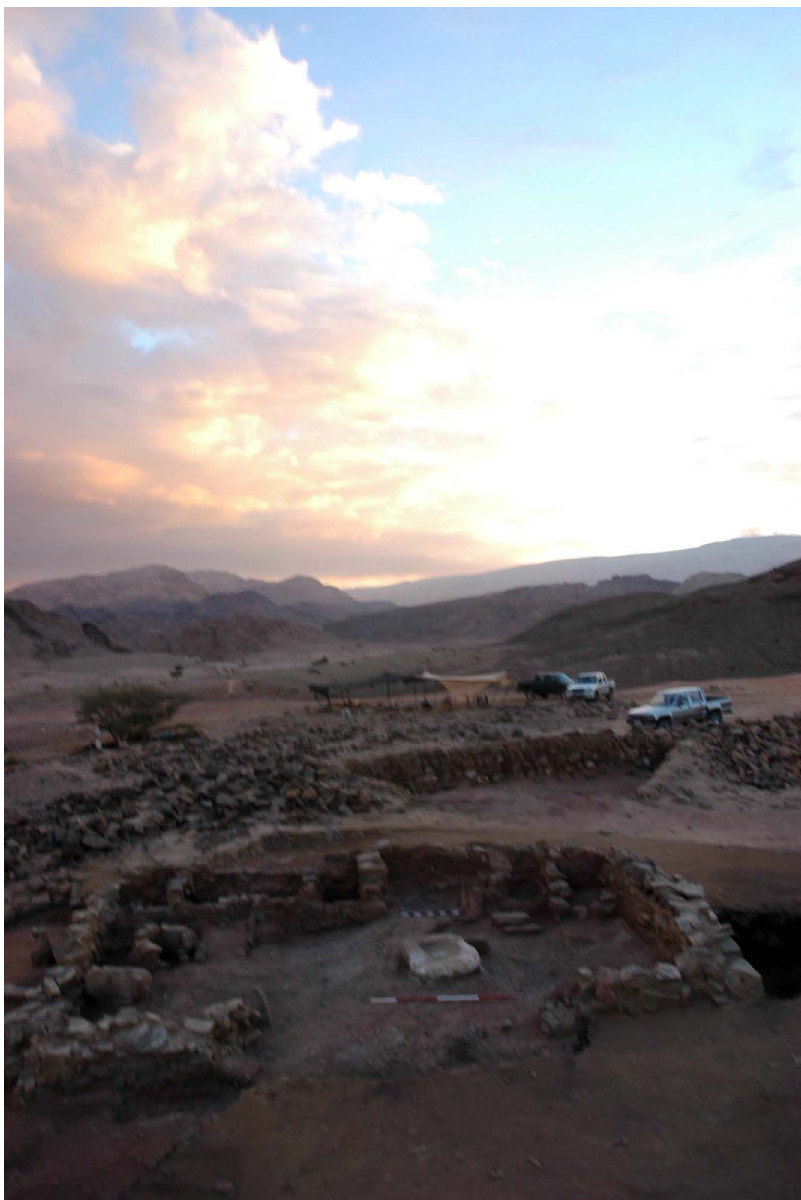
Figure 6. 2006 Khirbat en-Nahas excavation - Area F. (Source: Levy et al. 2014b.) Area